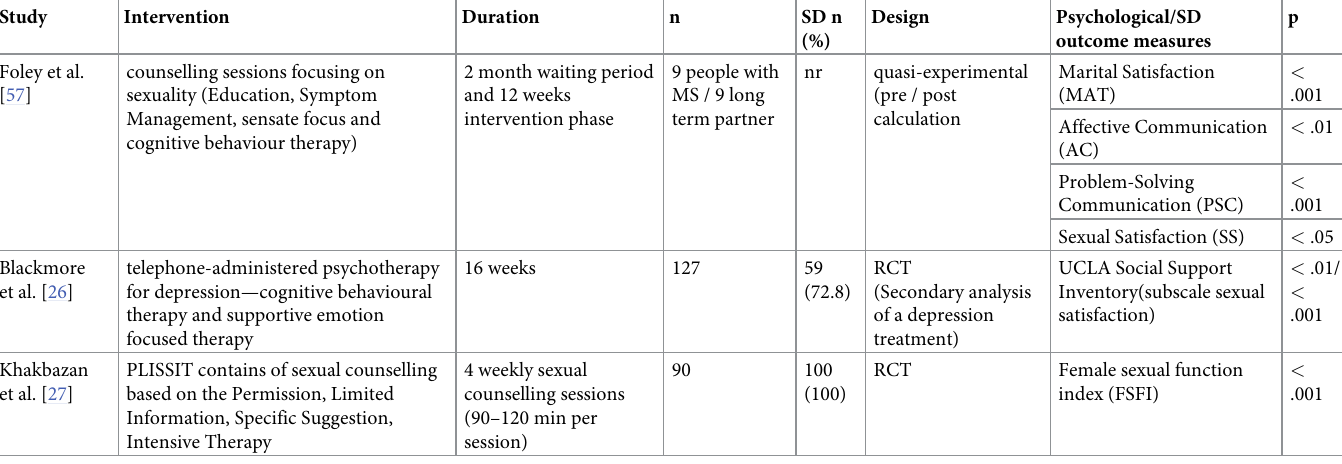
Table 4. Treatment effects for SD and psychological measures in intervention